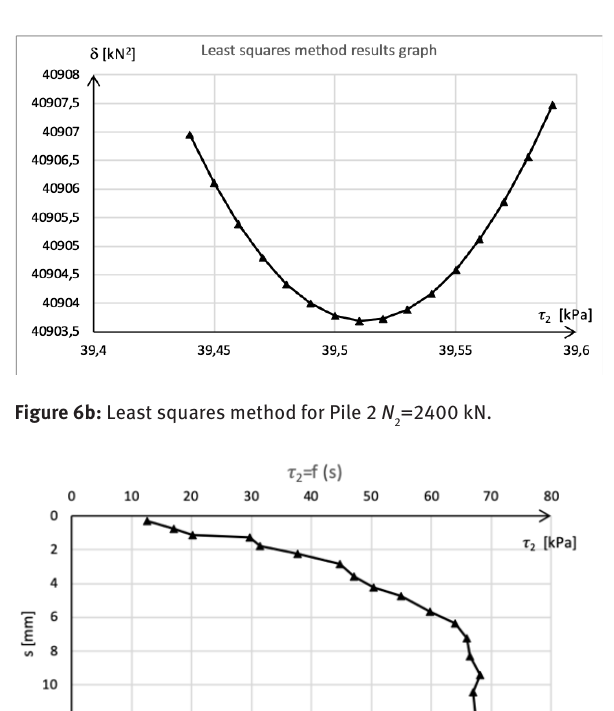
Figure 6a: Least squares method for Pile 1 N